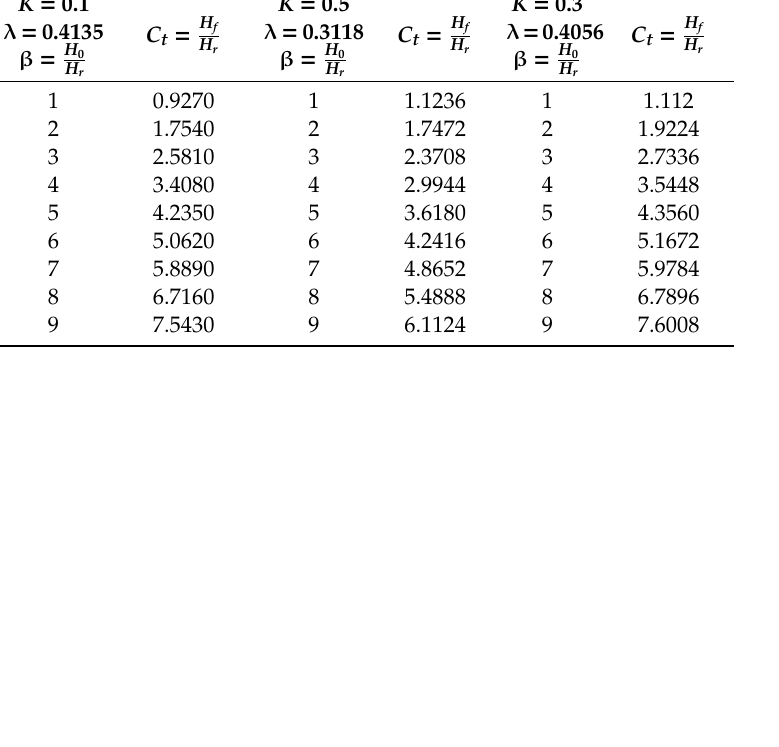
Table 4. E ff ect of β = H o